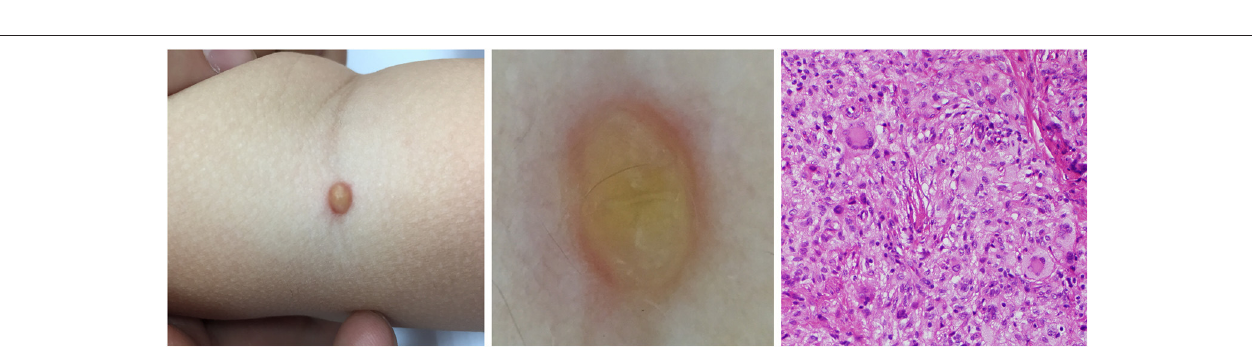
FIGURE 8 | Developed stage of JXG (Right) , H&E original magnification x40 with clinical (Left) and dermoscopic (Middle) correlations.